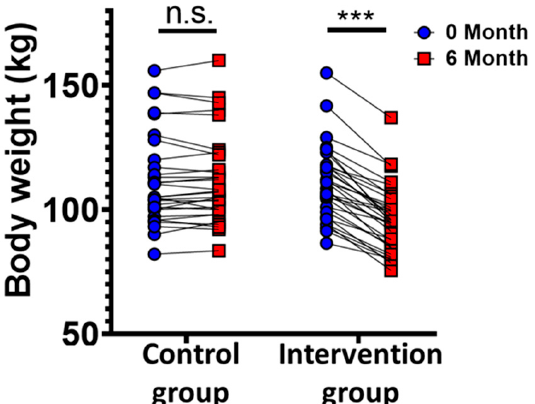
Figure 2. Line graph of total weight loss in both groups. Data is presented as total body weight in kg. The Wilcoxon signed-rank test was used to analyze differences between paired samples with n = 33 intervention, n = 30 control, *** p < 0.001.